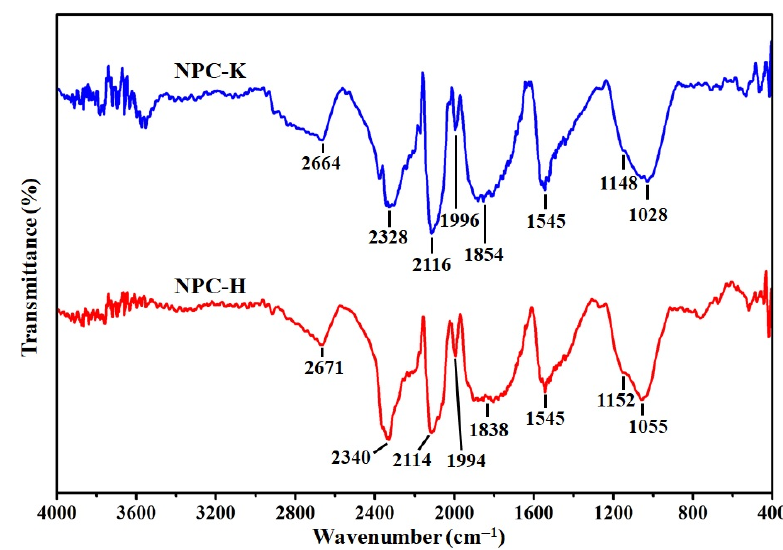
Figure 4. FTIR spectra of NPC-K and NPC-H samples.